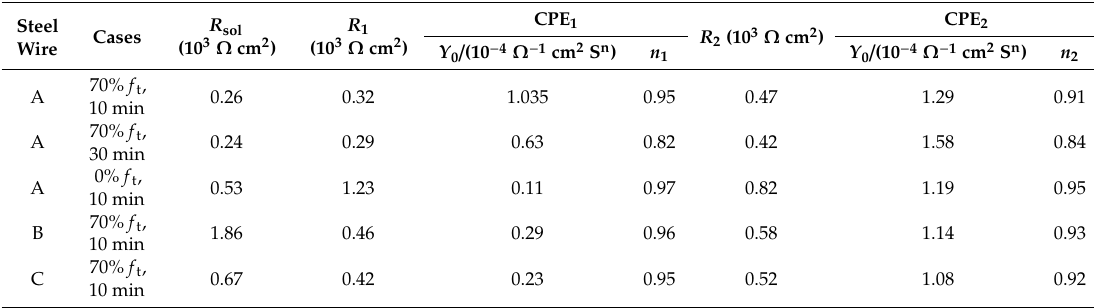
Figure 5. Equivalent electrical circuit used to represent the measured EIS data. Table 4. Fitting parameters for experimental EIS of wires immersed in NH 4 SCN